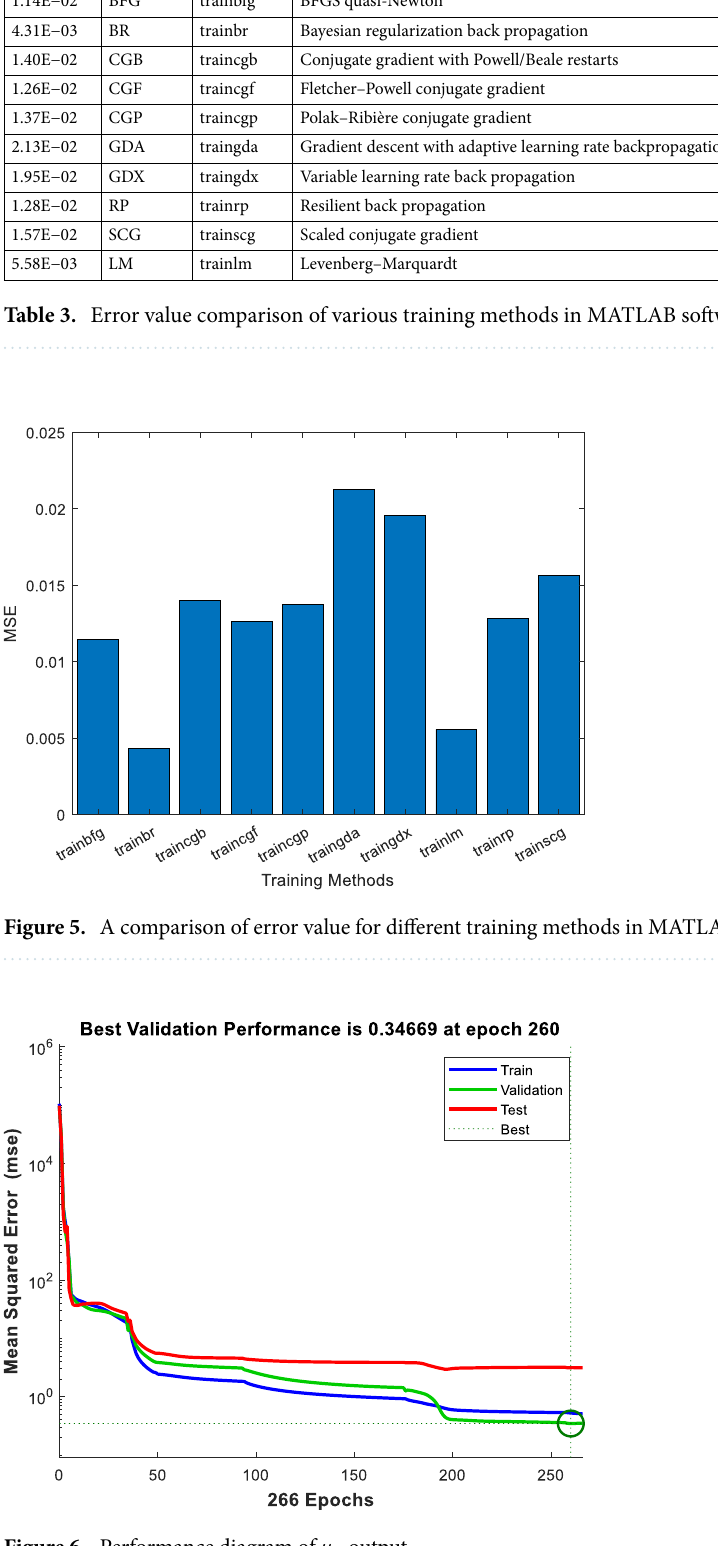
Figure 6. Performance diagram of μ nf